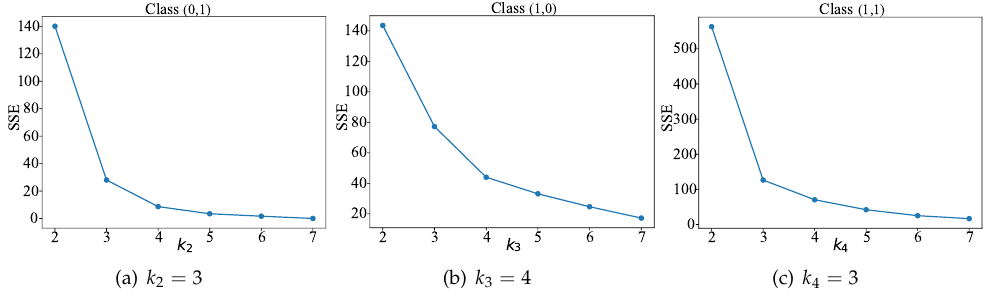
Figure 3. Select the optimal value of k i